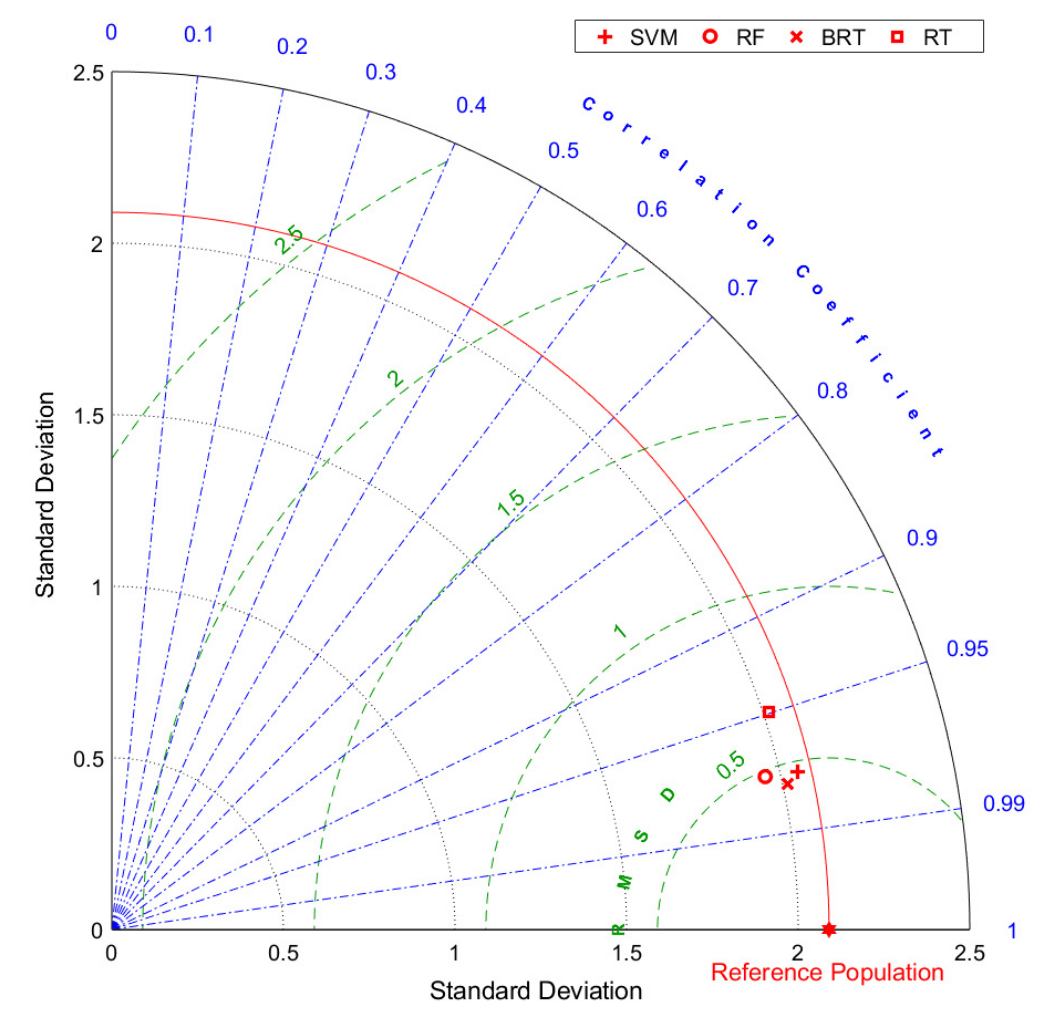
Figure 8. Taylor Diagram of the MLAs (Standard Deviations in black, R 2 in blue, RMSE in green,